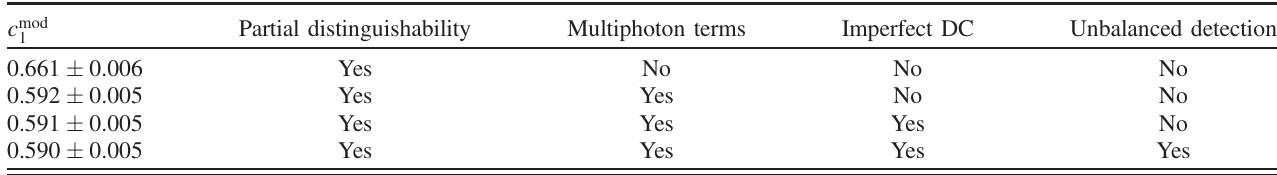
TABLE IV. Results of the numerical simulation for the experiment modeling. In particular, we have progressively added noise contributions for the configuration detailed in Sec. III B leading to an experimental value of c 1 ¼ 0 . 61 (cid:2) 0 . 01 . The corresponding parameters for such simulation are reported here. Brightness: B ∼ 0 . 098 . Second-order correlation: g ð 2 Þ ð 0 Þ ¼ 0 . 019 (cid:2) 0 . 001 . Directional coupler (DC) transmissivities: T 1 ∼ 0 . 503 , T 2 ∼ 0 . 508 , T 3 ∼ 0 . 505 , T 4 ∼ 0 . 507 , T 5 ∼ 0 . 506 , T 6 ∼ 0 . 512 , T 7 ∼ 0 . 5045 , T 8 ∼ 0 . 534 . ∼ 0 . 852 , x ∼ 0 . 883 , x ∼ 0 . 941 , x ∼ 0 . 932 . Detection imbalance: ˜ η 0 . 92 , ˜ η 0 . 90 , Indistinguishability parameters: x 1 ¼ 2 ¼ A B C D ˜